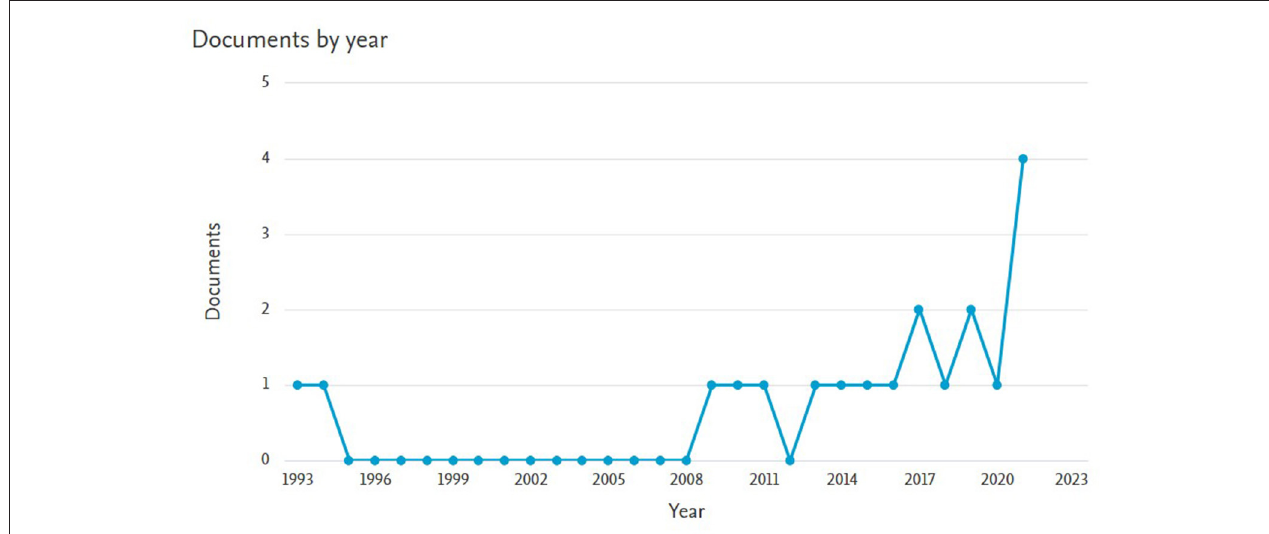
FIGURE 1 | Records found in Scopus for the keyword “THEME TPA.”